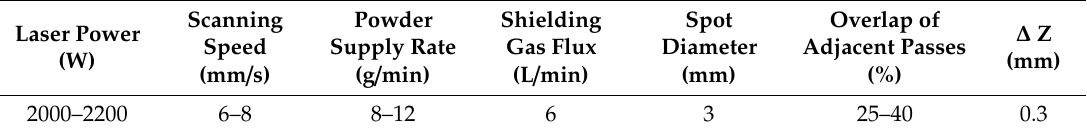
Table 2. Laser solid forming parameters of the Inconel 718